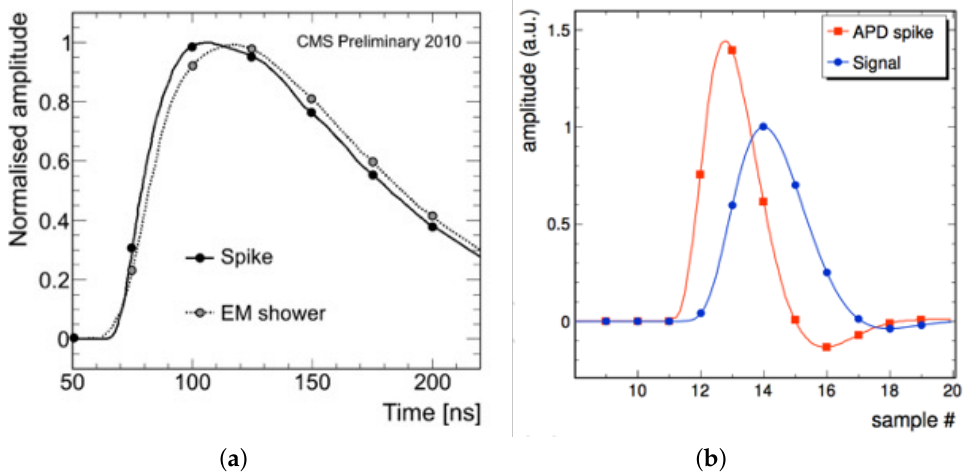
Figure 7. ( a ) Representative spike and EM shower pulse shapes in the current CMS ECAL, with the spike shown in black and the EM shower shown in grey. ( b ) Spike and EM shower pulse shapes in the CMS ECAL during the HL-LHC, with the spike pulse shown in red and the EM pulse shown in blue. HL-LHC pulse shapes are from the measured response of early prototype electronics convoluted with the known APD and scintillation pulse